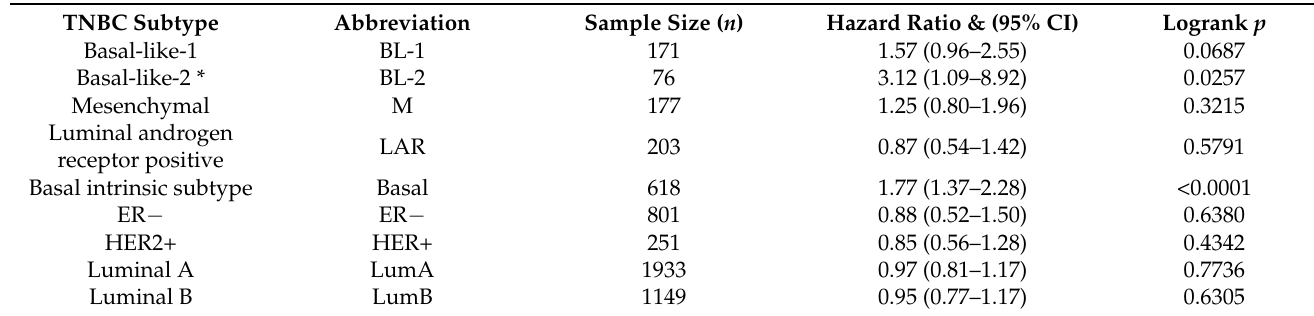
Table 1. Annexin A1 expression levels in primary breast tumors and outcome in different molecular subtypes of TNBC hazard ratios (H.R.s), 95% confidence intervals, logrank p values and sample sizes are shown. The clinical follow up was 200 months. * An upper tertile cut off was used for Annexin A1 mRNA expression in all analyses except BL-2 where a lower quartile cut off was used. ER, estrogen receptor. HER2, human epidermal growth factor receptor